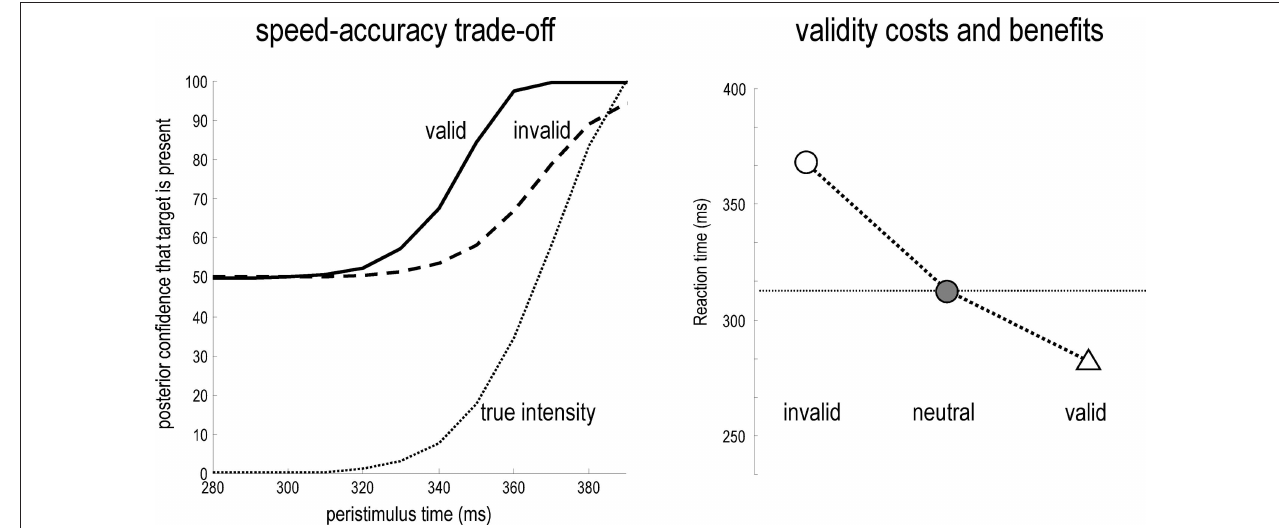
invalid targets (broken line) the same accuracy is only attained after about 360 ms. This translates into a reaction time advantage for valid targets of about 20 ms. Right panel: this shows the reaction times for invalid, neural and valid cues, where neutral cues caused a small reduction in precision but with no spatial bias. The reaction times here are shown to within an additive constant, to better reflect empirical data (see Figure 5 ).